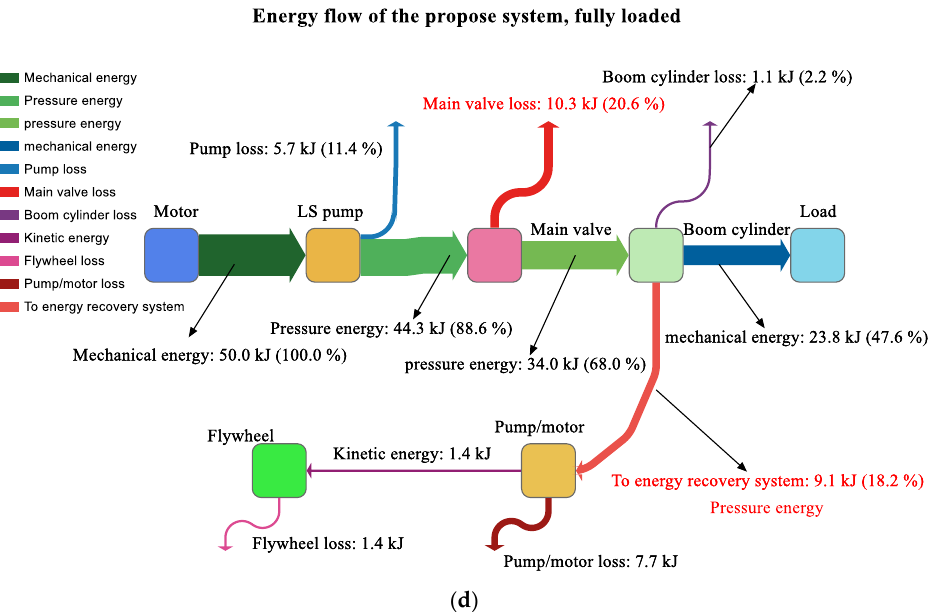
Figure 22. Sankey diagrams of energy flow. ( a ) The energy flow of the conventional load sensing system, non-loaded; ( b ) The energy flow of the conventional load sensing system, fully loaded; ( c ) The energy flow of the proposed system, non-loaded; ( d ) The energy flow of the proposed system, fully loaded.